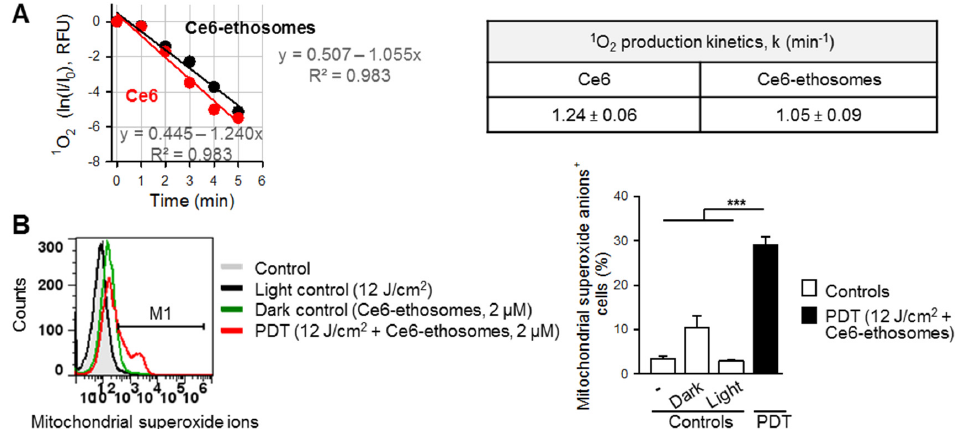
1 O 2 production